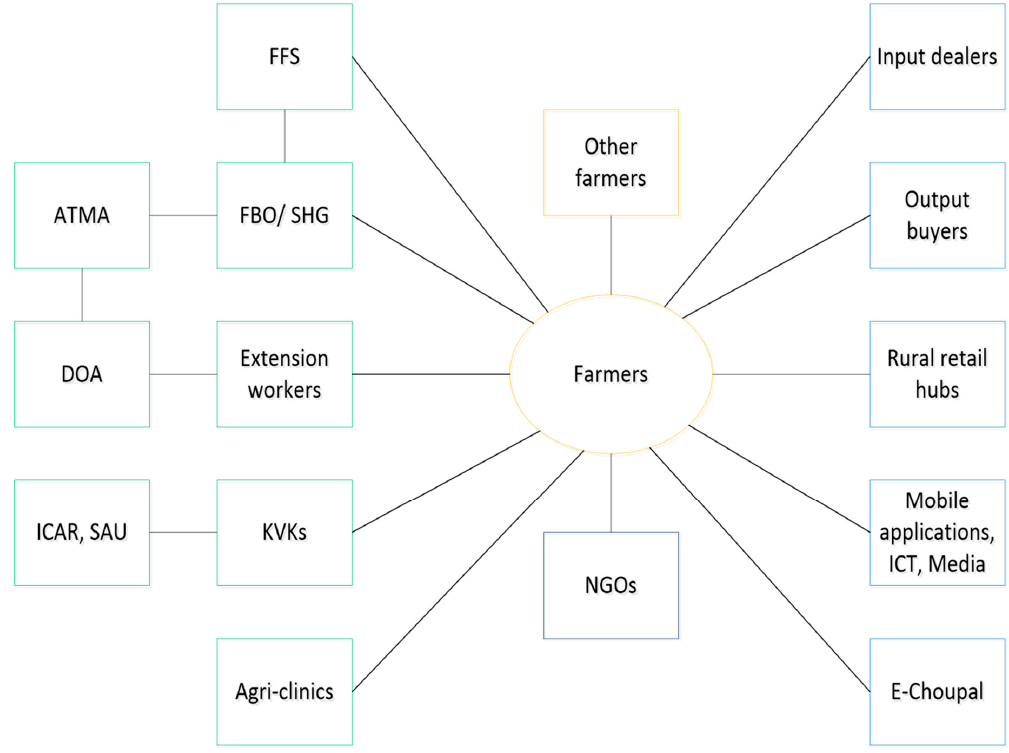
Figure 1. Information exchange between extension and farmers in India. Source: Glendenning et al., 2010. Notes: Information flow is shown by the line linking the boxes. The green boxes refer to the public sector, and the blue ones to the Private sector. ATMA denotes Agricultural Technology Management Agency, DoA denotes Department of Agriculture, ICAR denotes Indian Council for Agricultural Research, FFS denotes farmer field school, FBO/SHG denotes farmer-based organization/self-help group, SAU denotes state agricultural university, KVK denotes Krishi Vigyan Kendra (farm science center), and NGO denotes non-governmental organization.